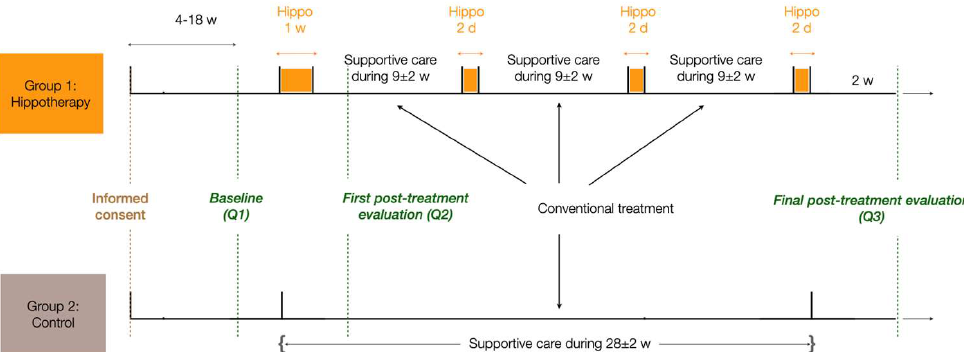
Figure 1. Timeline of the clinical trial: conventional support care was provided to the control group over 28 weeks, whereas the hippotherapy group received conventional supportive care for the same time, minus the days where they received the hippotherapy treatment. The aim of such a design was to prevent an unequal amount of care among groups.